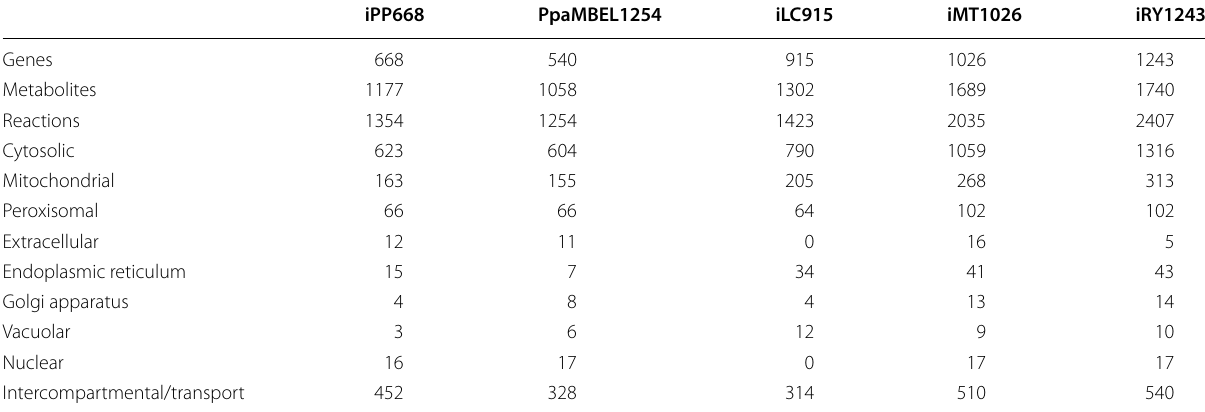
Table 2 Comparison among different GSMMs of P.